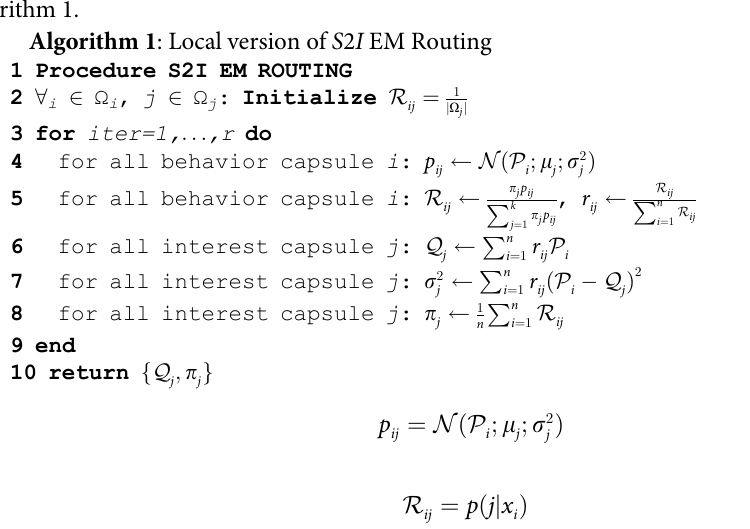
Algorithm 1 : Local version of S 2 I EM